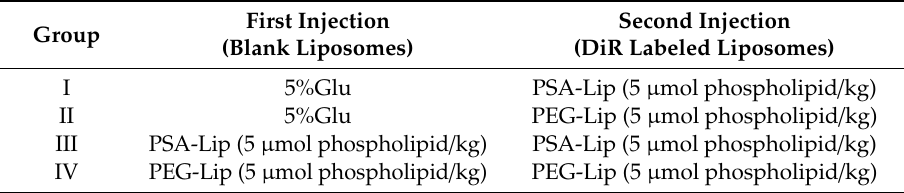
Table 2. The injection scheme of PSA-Lip and PEG-Lip in beagle dogs.